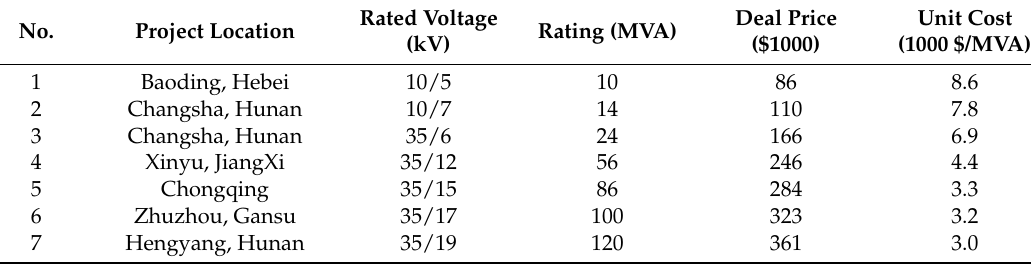
Table A3. Deal prices of several 10 MVA-class rectifier transformers in